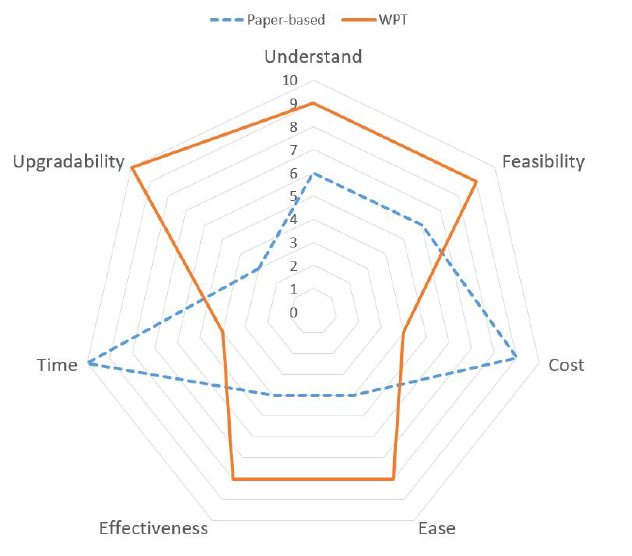
Figure 14. WPT system evaluation